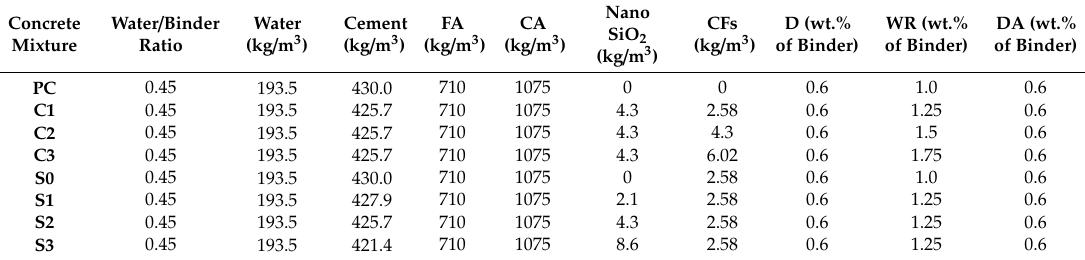
Table 2. Details of mixture proportions per unit volume of